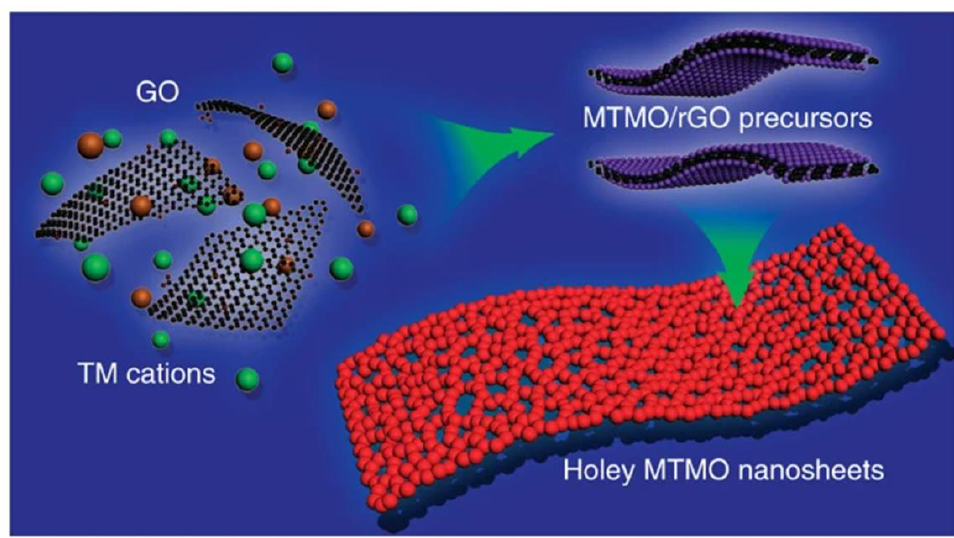
Figure 3. Schematic illustration of the general synthetic strategy of 2D holey TMO nanosheets. Reprinted with permission from Ref. [33]. Copyright 2012 American Association for the Advanced Energy Materials.